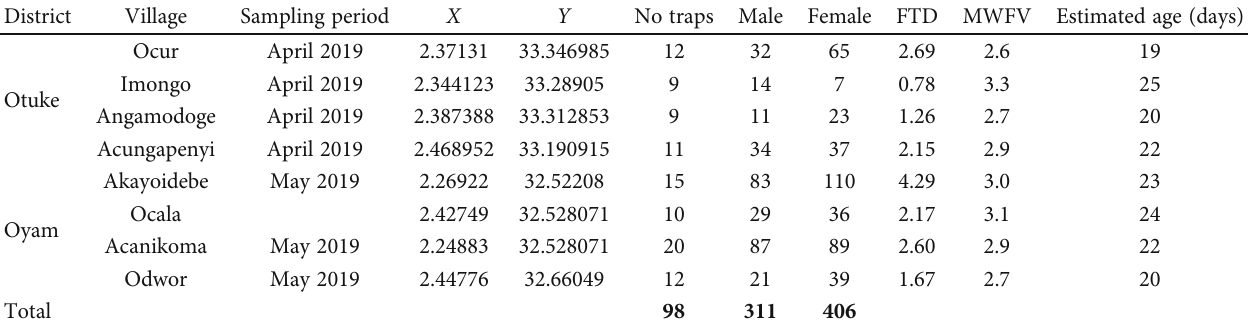
Table 1: Entomological data of tsetse captured in Oyam and Otuke